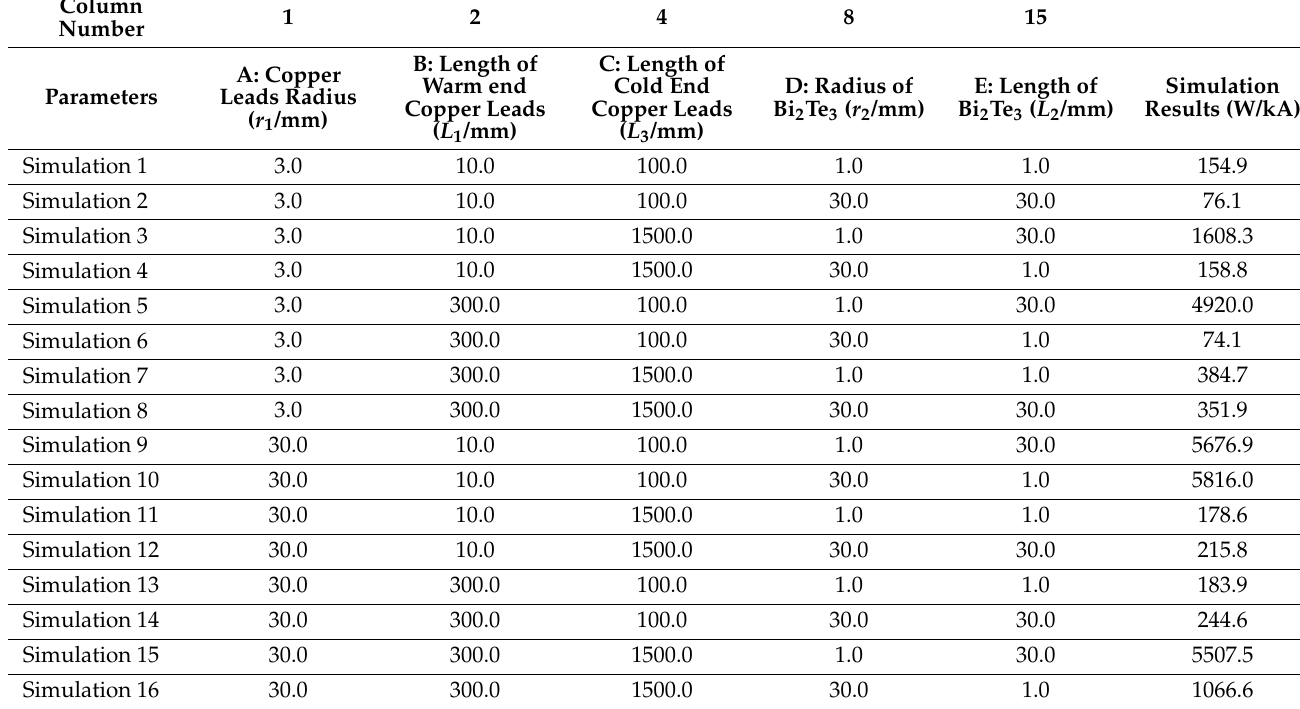
Table A1. Orthogonal experimental schedule for 120 A PCLs.